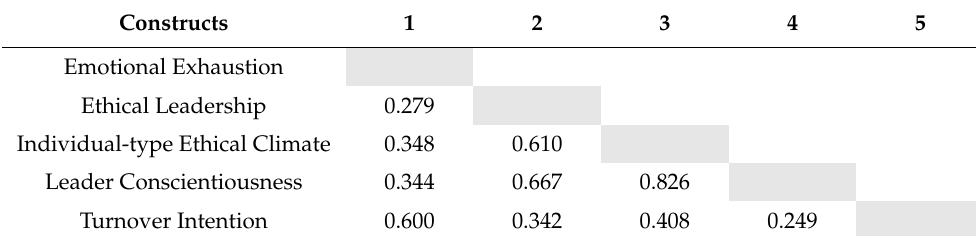
Table 4. Discriminant validity based on heterotrait–monotrait (HTMT) criterion.